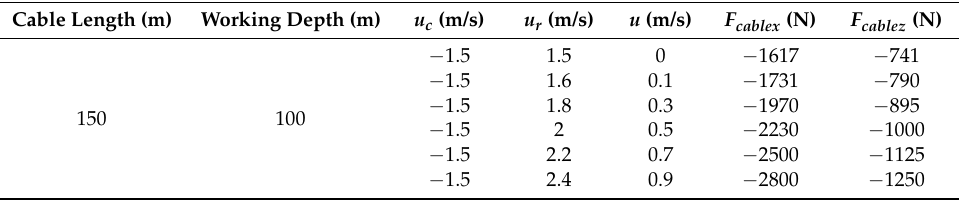
Table 4. Tension on the ROV under different relative velocity